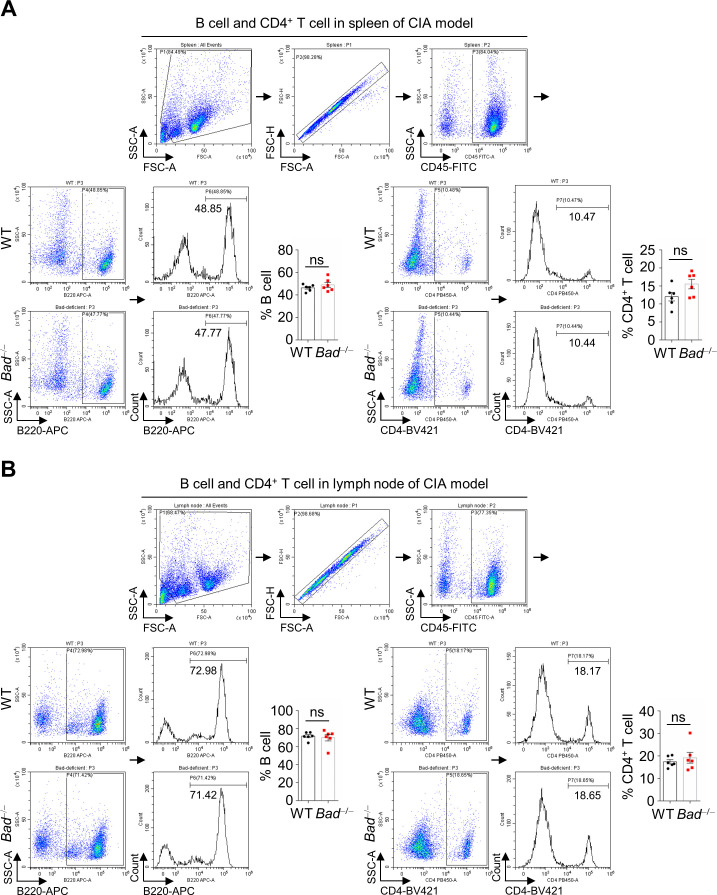
The number of B cell and CD4+ T cell in spleen and lymph node (LN) has no significant difference between wild-type (WT) and Bad−/− mice in collagen-induced arthritis (CIA) model.(A) The percentages of B cell and CD4+ T cell in the spleen of WT and Bad−/− mice in CIA model were determined by flow cytometry. (B) The percentages of B cell and CD4+ T cell in the LN of WT and Bad−/− mice in CIA model were determined by flow cytometry. All data are presented as mean ± SEM, dots represent individual mice, and n = 6 for each group. Significant difference was analyzed by unpaired Student’s t-test.